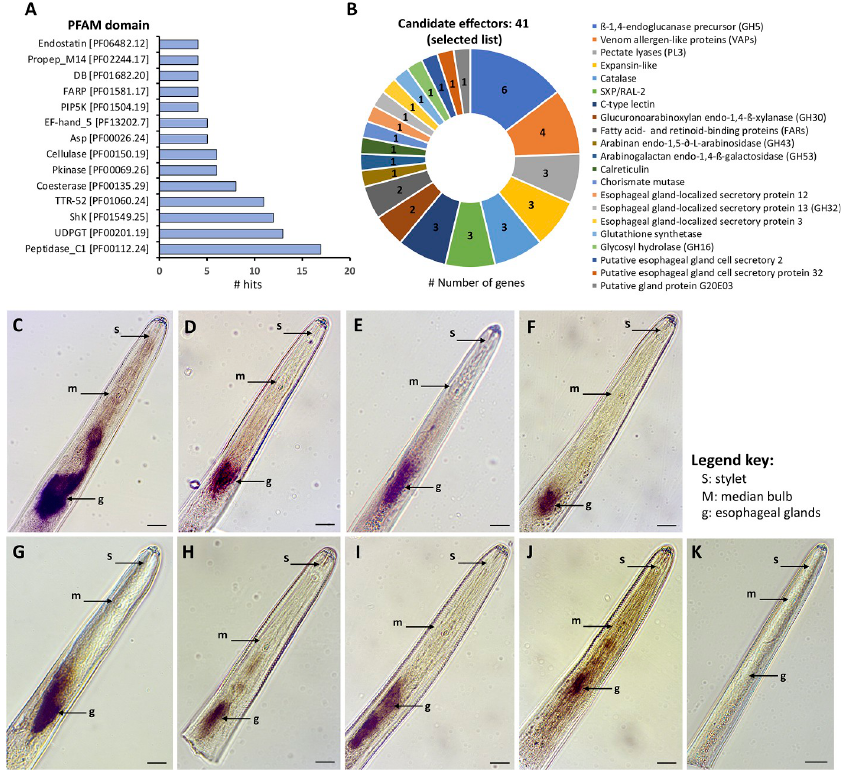
Fig 2. Identification of known candidate effector genes identified in the esophageal gland cell library of Radopholus similis by in silico analyses. (A) Top most abundant PFAM protein domains represented within the list of 542 transcripts coding putative secreted proteins. (B) List of selected known candidate effector genes present in the esophageal glands library of R . similis . (C-J) Detection of gene transcripts encoding putative secreted proteins in the esophageal glands of R . similis by in situ hybridization. (C) ß-1,4-endoglucanase (positive control, g11661.t1), (D) ß- 1,4- endoglucanase (g4814.t1), (E) pectate lyase (g460.t1), (F) expansin-like (g15237.t1), (G) venom allergen-like (g14608.t1), (H) ShK-Like domain protein (g11934.t1), (I) glutathione synthetase (g13505.t1), (J) Extracellular solute- binding protein (g10597.t1). (K) Example of a control image obtained using the sense probe (e.g. g460.t1). Bars = 20 μ m.